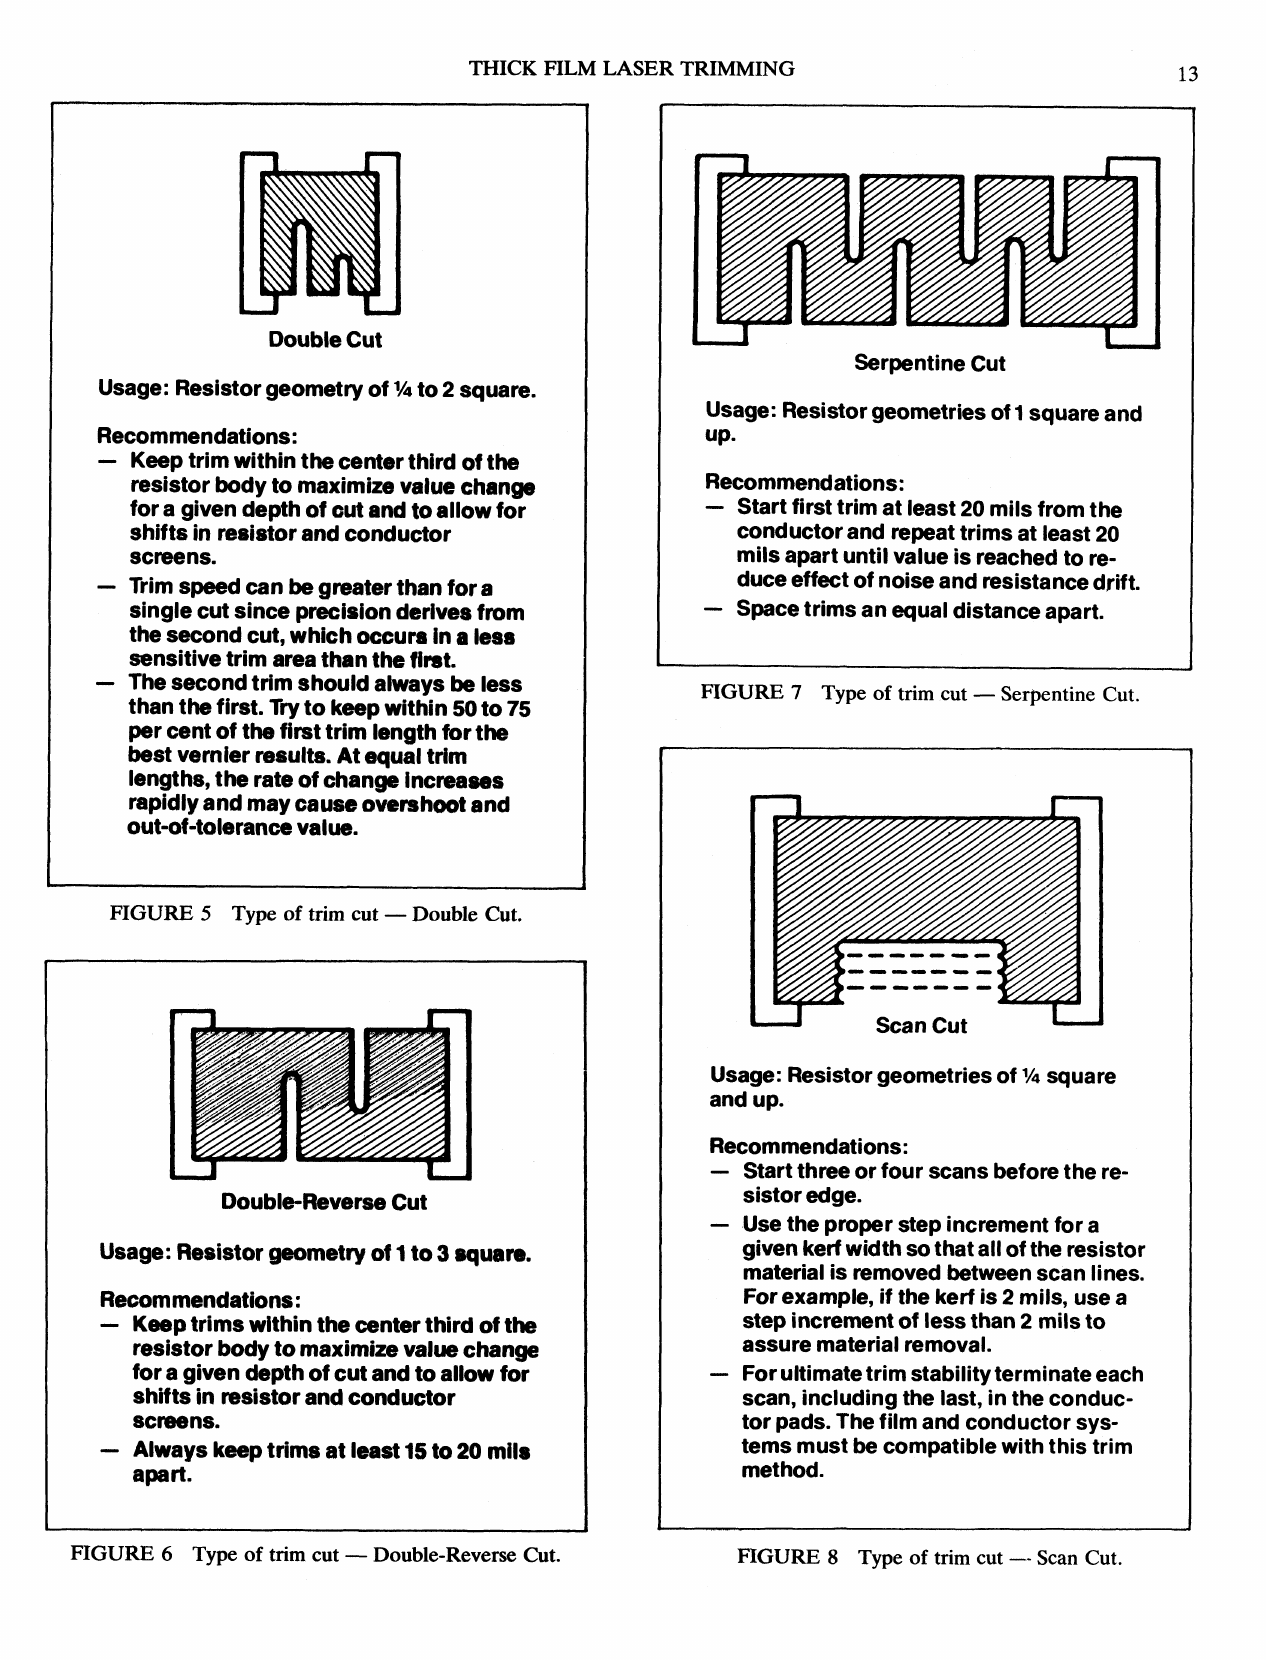
FIGURE 6 Type of trim cut- Double-Reverse